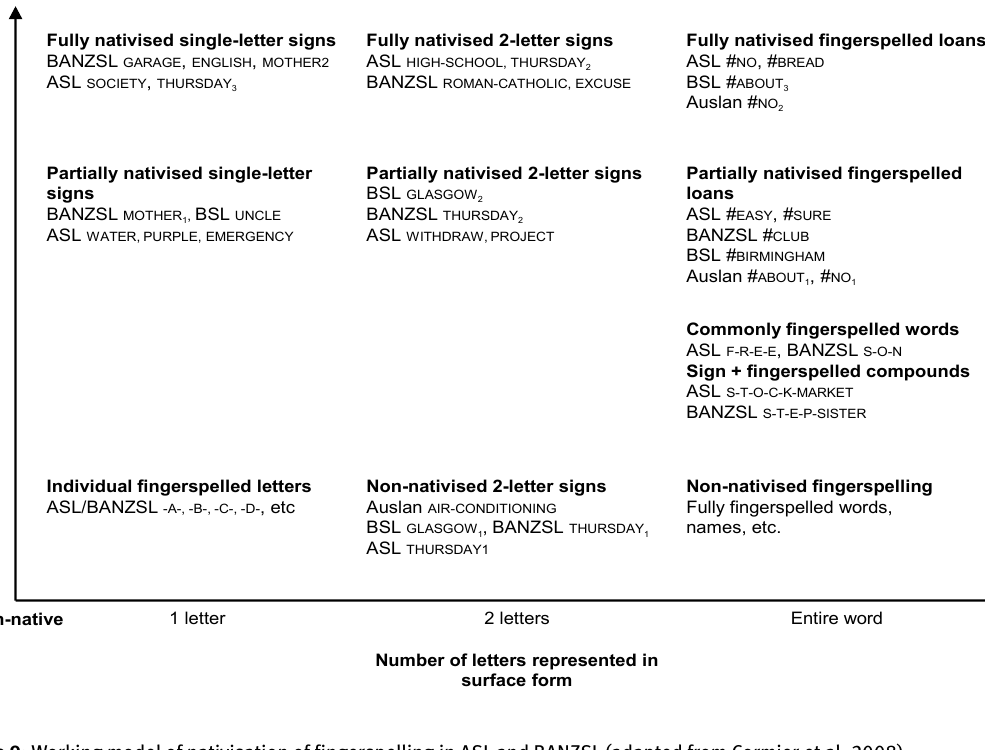
Figure 9: Working model of nativisation of fingerspelling in ASL and BANZSL (adapted from Cormier et al.